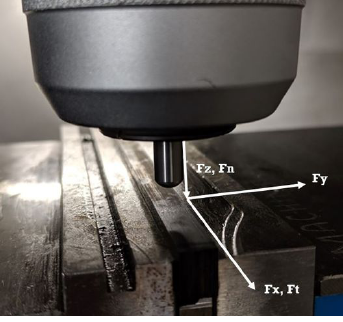
Figure 5. Axis of force